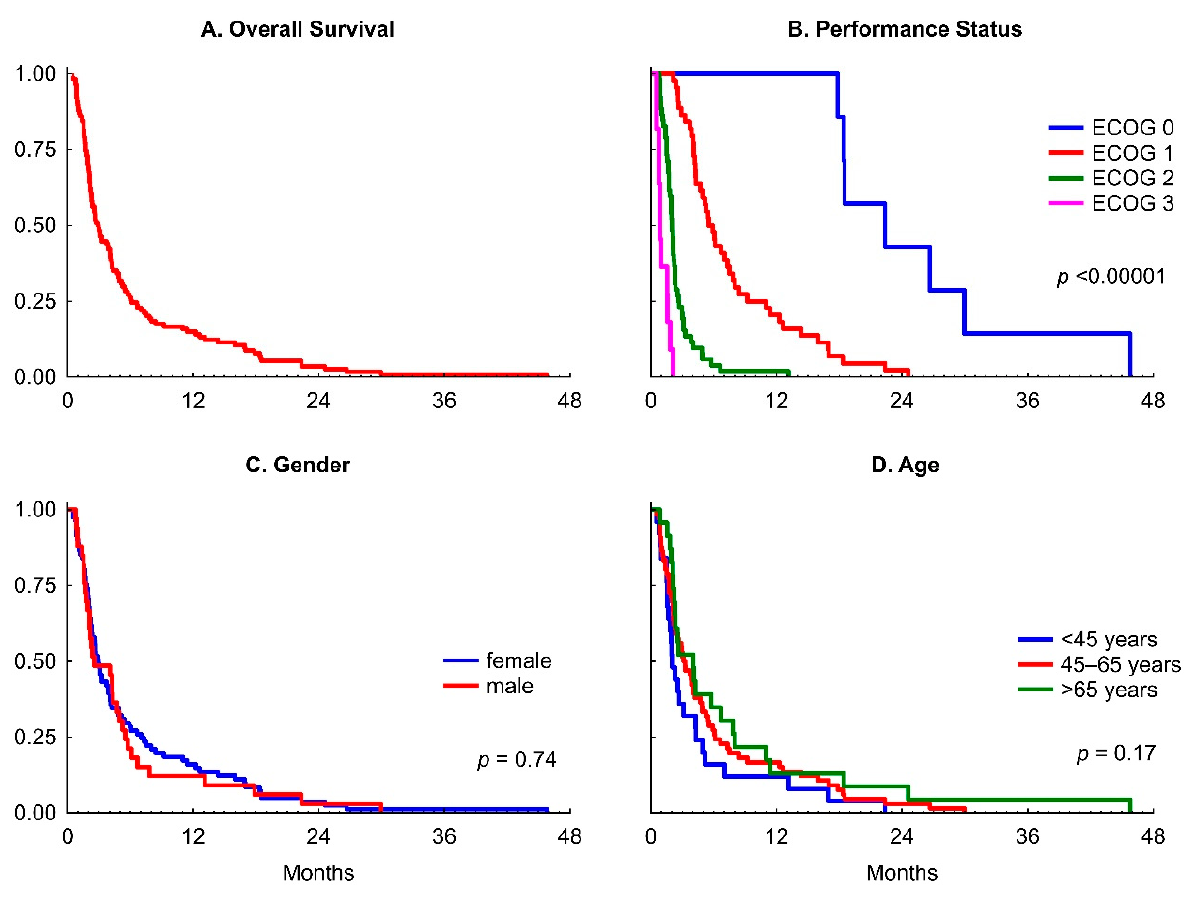
Figure 1. The Kaplan–Meier curves for overall survival and in subgroups: ( A ) overall survival; ( B ) performance status; ( C ) gender; ( D ) age.